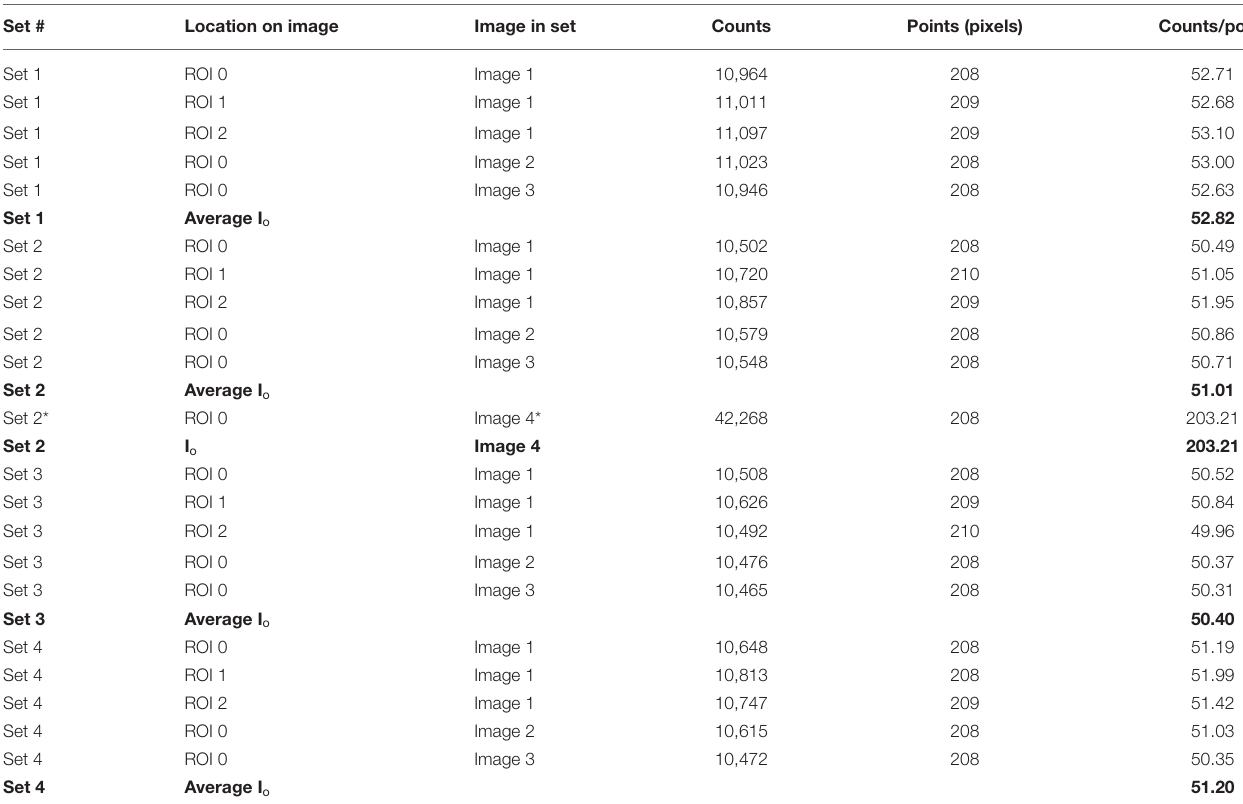
TABLE 3 | Counts per point in unobstructed regions of interest in each of 4 image sets. Set